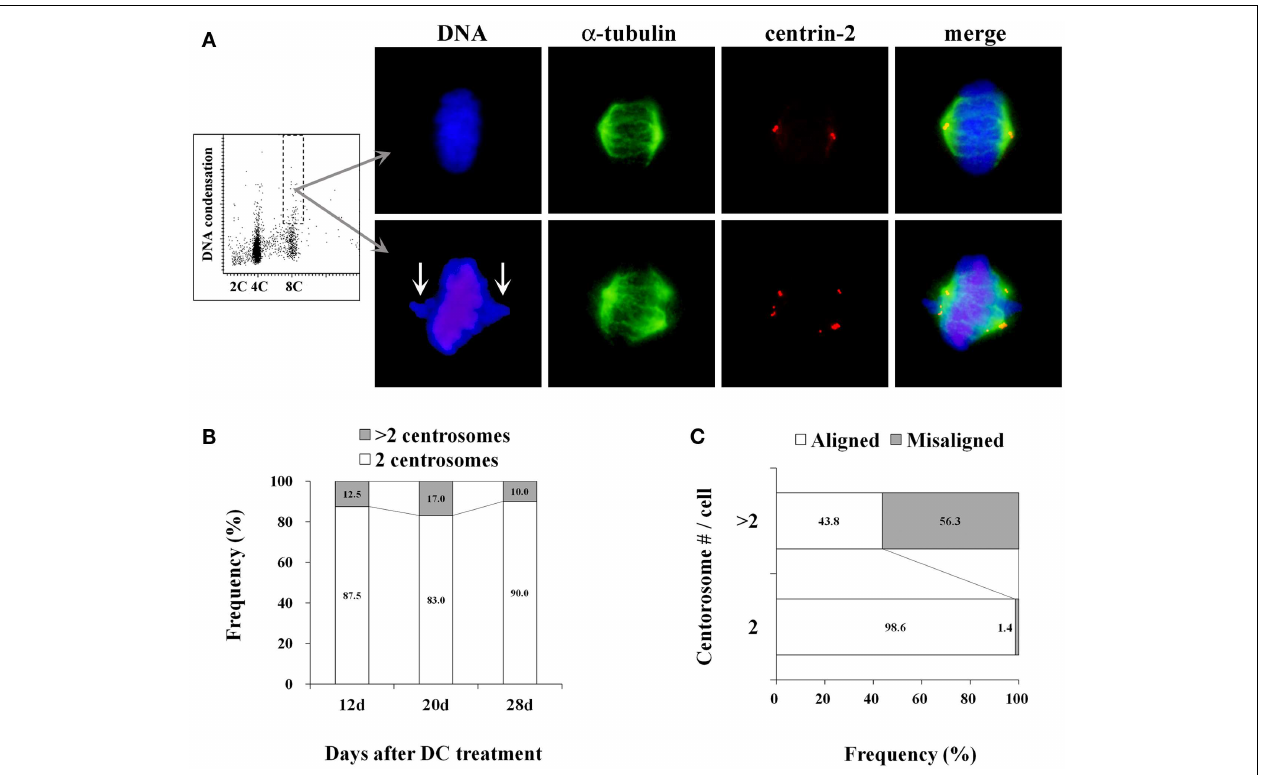
centrosomes and excess centrosomes in established tetraploid cells. Number of centrosomes was scored in at least 50 mitotic cells per time point after DC treatment. Numbers in the accumulated bar graphs represent frequencies of cells with the given number of centrosomes. (C) The correlation between centrosome number and chromosome misalignment in tetraploid metaphase cells.The frequency of metaphase cells with aligned and misaligned chromosomes in pooled data from all time points shown in (B) was calculated according to the centrosome number. Numbers in the accumulated bar graphs represent frequencies of metaphase cells with aligned and misaligned